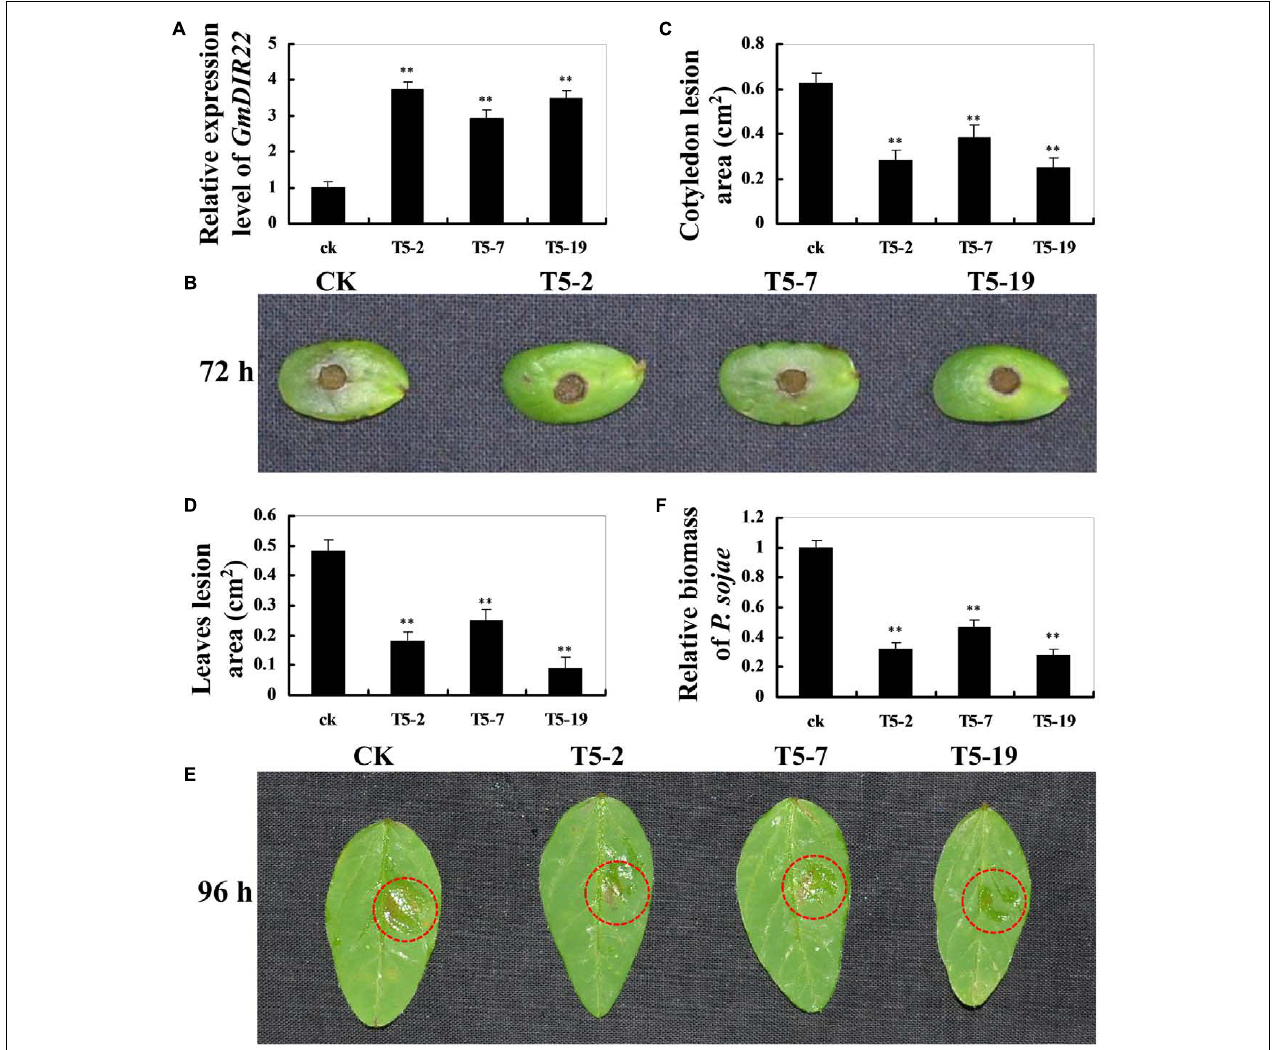
FIGURE 6 | Resistance analysis of GmDIR22 transgenic soybean plants to P. sojae infection. (A) The qRT-PCR results demonstrating the relative abundance of GmDIR22 in transgenic soybean plants. (B,E) The disease symptoms on the living cotyledons and detached leaves of transgenic lines treated with P. sojae inoculum at 72 h and 96 h, respectively. (C) The relative lesion area of transgenic soybean cotyledons infected with P. sojae after 72 h of inoculation. (D) The relative lesion area of transgenic soybean leaves infection with P. sojae after 96 h of inoculation. (F) qRT-PCR analysis of P. sojae relative biomass based on the transcript level of the P. sojae TEF1 gene in infected living cotyledons after 72 h of inoculation. Experiments were performed using three biological replicates with three technical replicates each, and statistically analyzed using Student’s t -tests ( ∗ P < 0.05, ∗∗ P < 0.01). Bars indicated standard errors of the